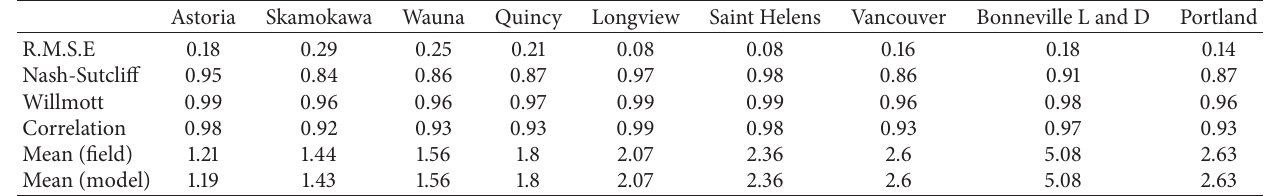
Table 2: Statistical analysis for observation